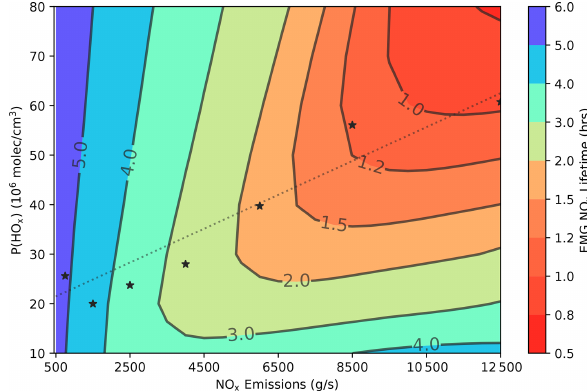
Figure 6. Isopleth showing the NO x lifetime dependence on NO x emissions versus P (HO x ) . We run the PECANS 1-D model with varying NO x emissions and P (HO x ) . The lifetime is estimated by fitting the modeled NO x concentration along the wind direc- tion with the EMG function (Eqs. 7 and 8). We run the model at a constant wind speed of 5ms − 1 , and the VOC reactivity is set con- stant at 4.8s − 1 for both groups (RVOC and OVOC). The black stars show the TROPOMI-observed mean NO x emissions and lifetimes at wind speeds between 4 to 6ms − 1 , where the P (HO x ) value is estimated as the level that gives the closest NO x lifetime as observa- tions at given NO x emissions. The dashed line represents the fitted regression